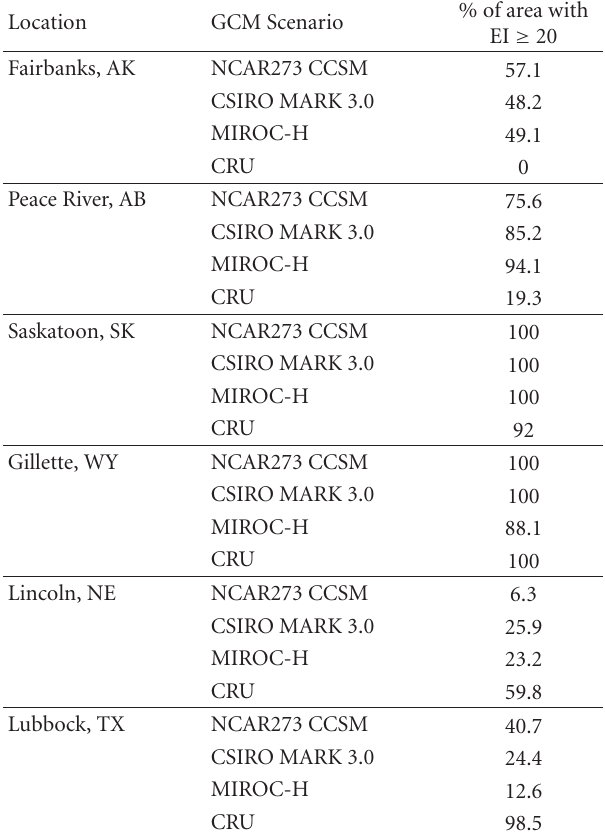
Table 3: Baseline (CRU) and general circulation model (NCAR273 CCSM, MIROC-H, and CSIRO MARK 3.0) scenarios and percent of area with EI values greater than, or equal to, 20 for Melanoplus sanguinipes at six locations in North